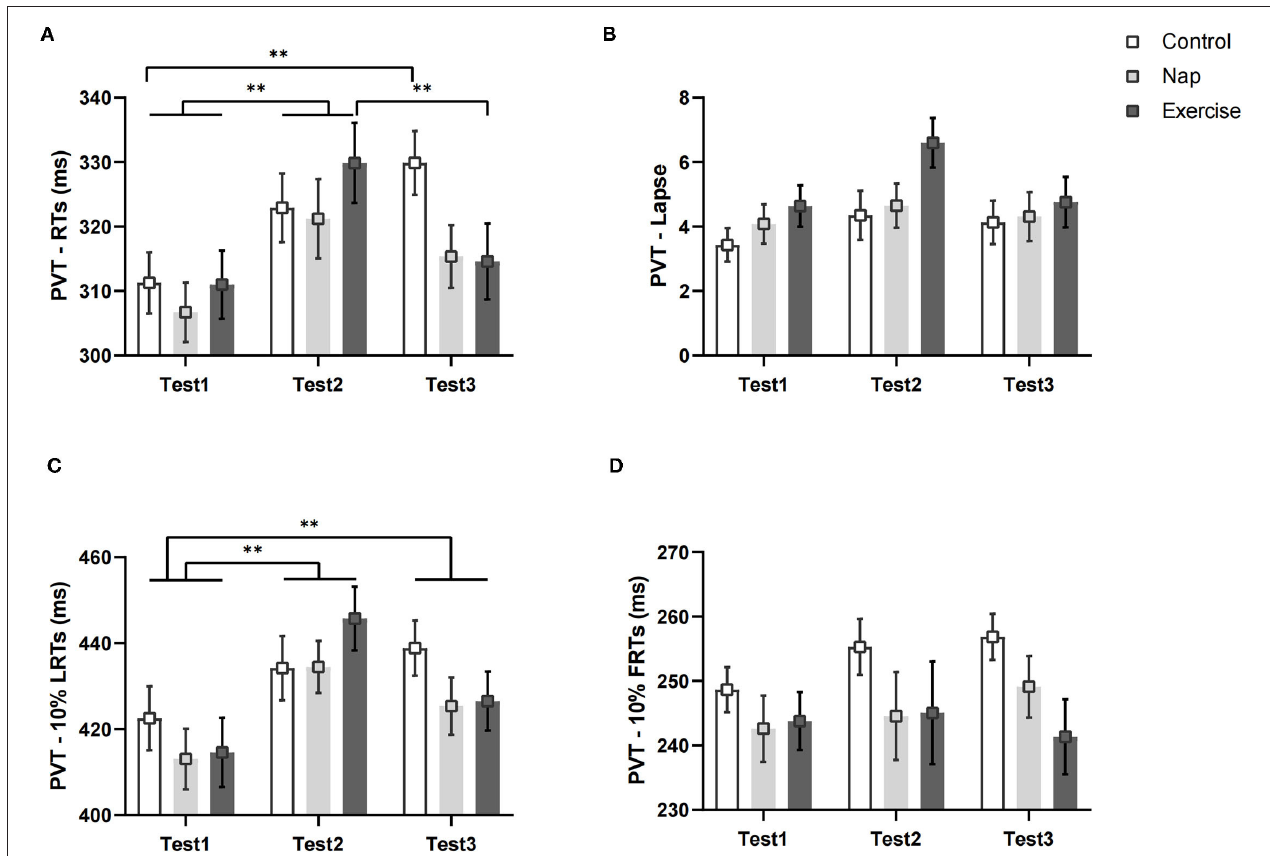
FIGURE 4 | PVT performance. (A) Average reaction speed for all valid trials; (B) lapse probability; (C) average reaction speed for the slowest 10% of the trials; (D) average reaction speed for the fastest 10% of the trials. Error bars represent one standard error of the mean. ** p <